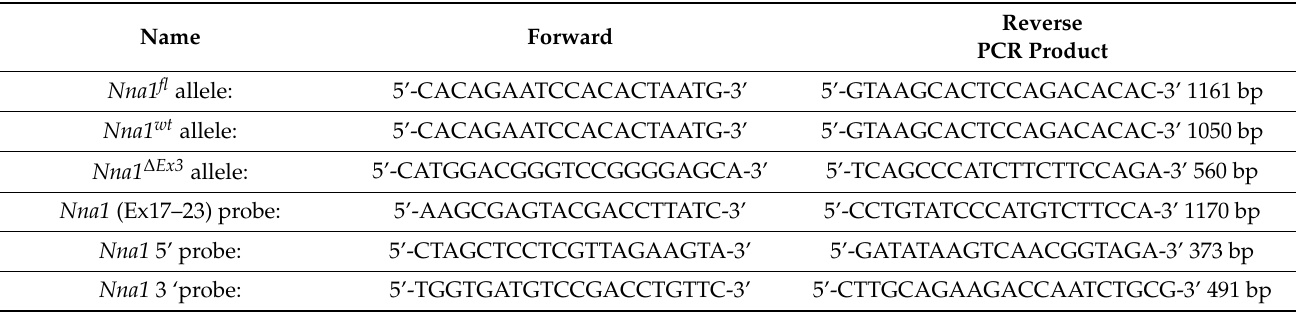
Table 1. PCR primers used for genotyping and generation of Nna1